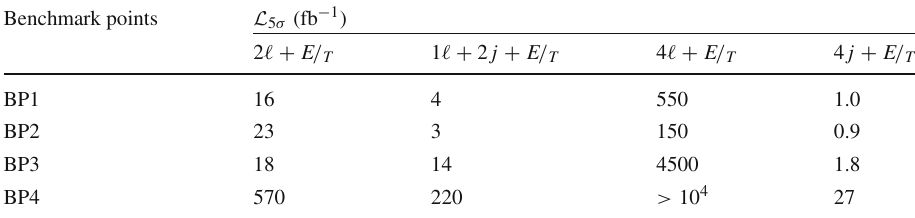
Table 17 Required integrated luminosity for 5 σ